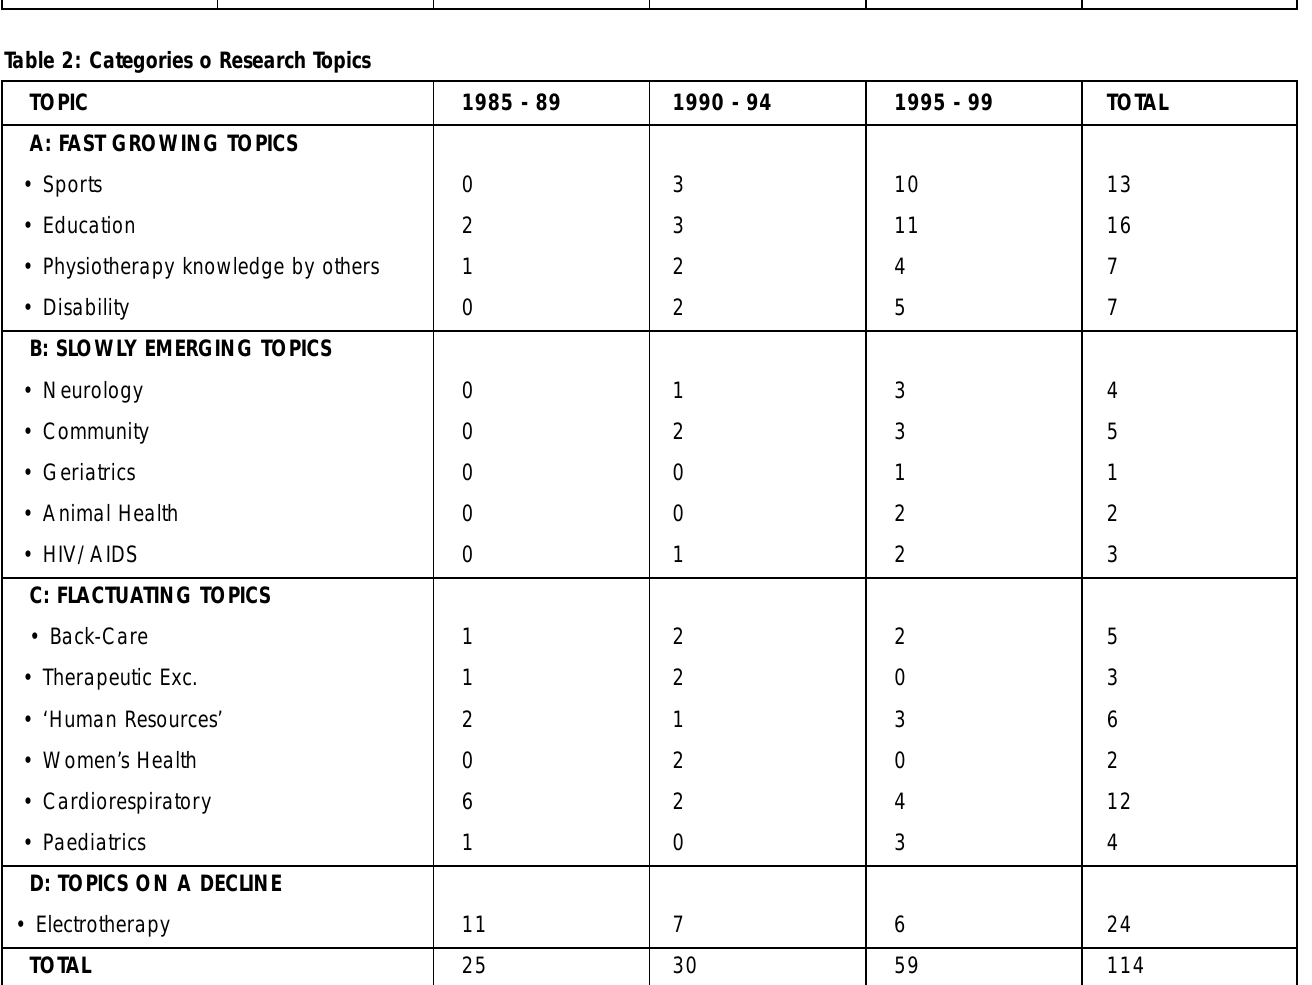
Table 2: Categories o Research Topics